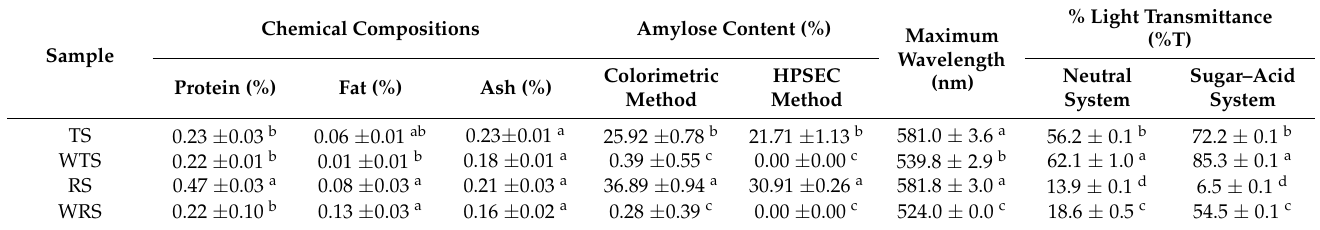
Table 1. Chemical compositions, amylose content, maximum wavelength, and light transmittance of native starches.